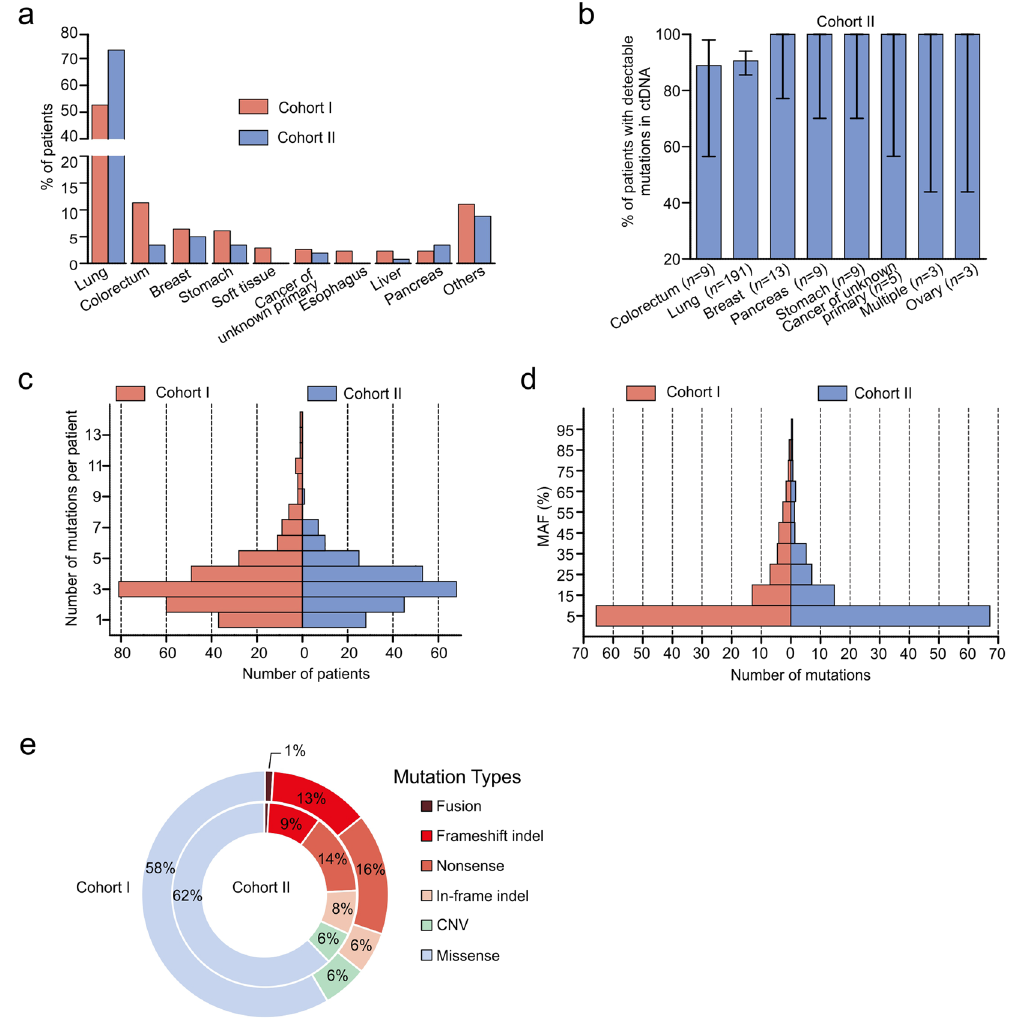
Figure 4. Similar ctDNA results between cohorts I and II. ( a ) There was a comparable distribution of tumor types covered in both cohorts I and II. ( b ) The fraction of patients with detectable ctDNA mutations in cohort II. ( c ) The distribution of mutation numbers identified per patient in cohorts I and II. ( d ) The distribution of MAFs in cohorts I and II. No significant difference was detected between the two cohorts in c and d by Mann- Whitney U test. ( e ) The distribution of different mutation types in cohorts I and